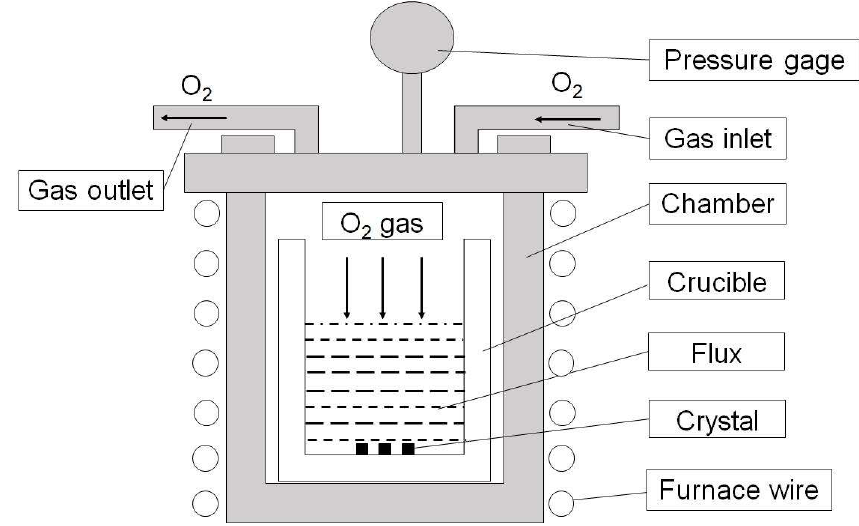
Figure 1. Scheme of reaction chamber within the furnace.